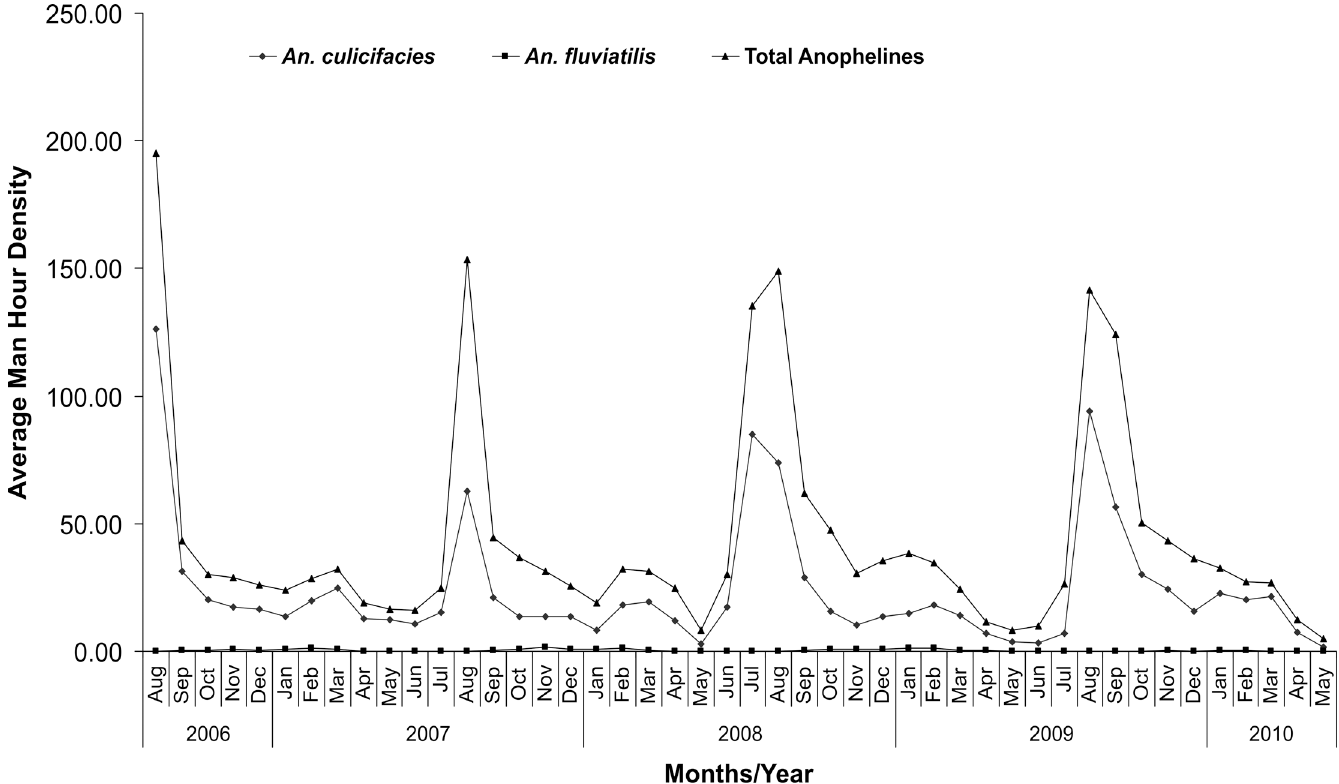
Fig 2. Month/Year wise man hour density (Indoor Resting Collections) in study villages of district Jabalpur.